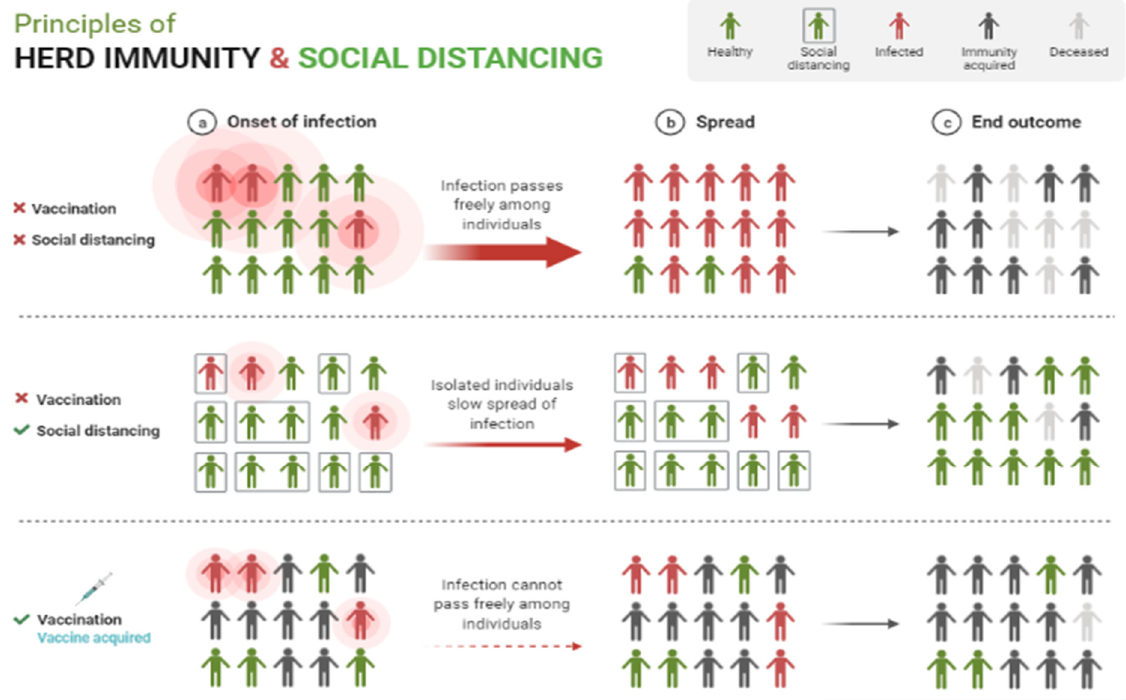
Figure 7. How a pandemic end by incorporating vaccination and social distancing to achieve herd immunity. Adapted from “Principles of Herd Immunity and Social Distancing” (source: https://app.biorender.com; accessed on 3 February 2022).